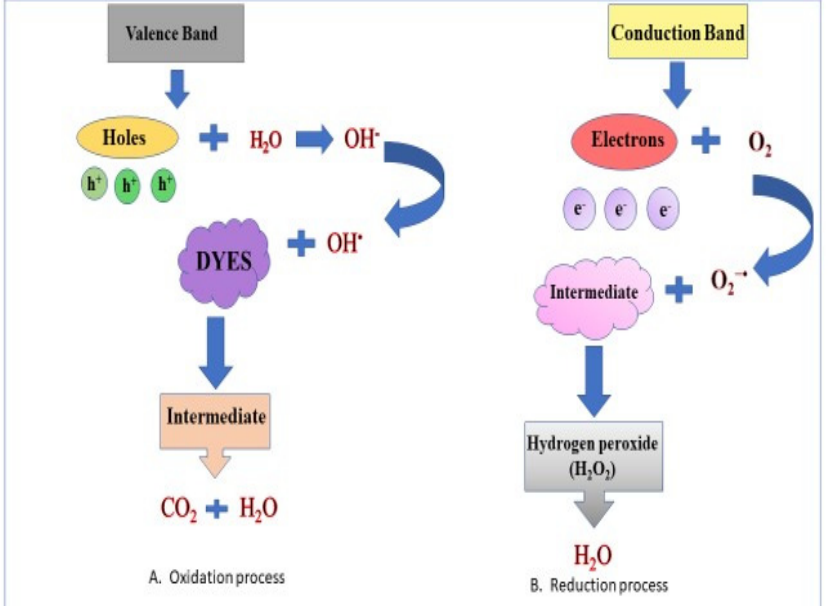
Fig. 8. Pictorial representation of degradation mechanism of